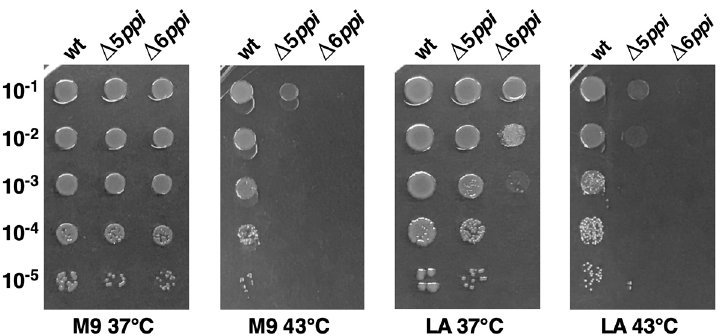
Figure 1. ∆ 6 ppi bacteria are unable to grow at either 37 or 43 ◦ C on LA medium. Exponentially grown cultures of the wild type and its isogenic ∆ 5 ppi and ∆ 6 ppi derivative were adjusted to an optical density OD 600 0.1 and serially spot diluted on M9 minimal medium and LA medium. Data presented are from one of the representative experiments. Table 1. The essentiality of peptidyl-prolyl cis / trans isomerases (PPIs) in the wild-type strain BW25113 in Luria Agar (LA) medium as revealed by bacteriophage P1-mediated transductional e ffi ciency criteria. Numbers indicate obtained transductants / mL of recipient. Data are from one of the representative experiments with several repeats.